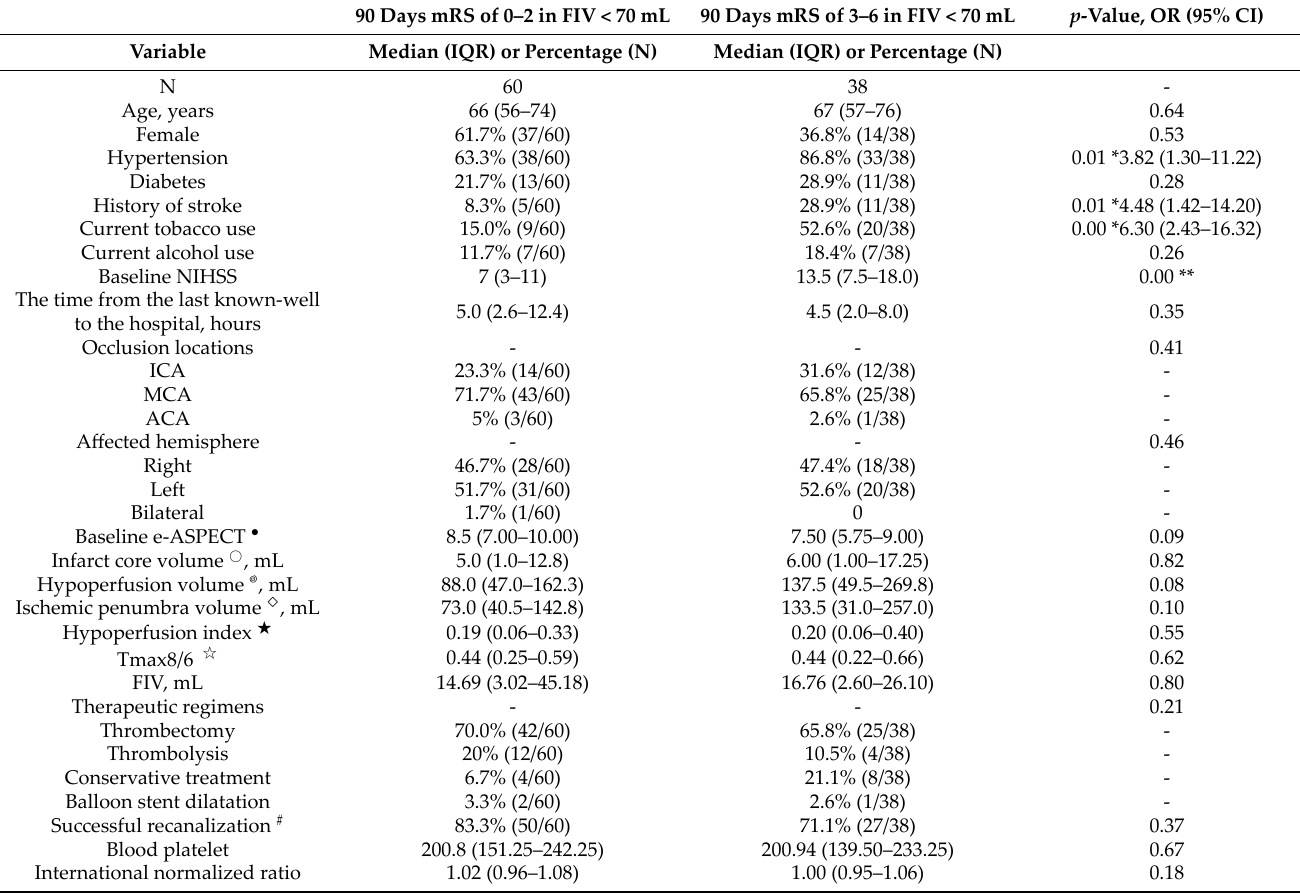
Table 4. The discrepancies between different functional outcomes in FIV < 70